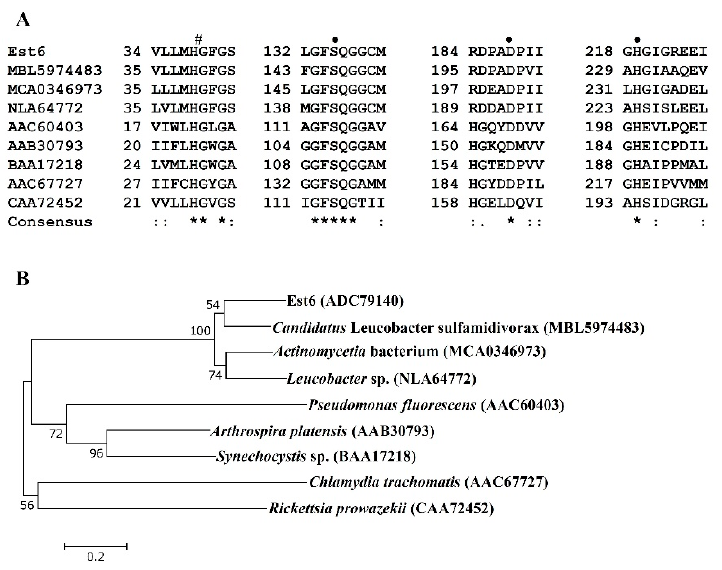
Figure 1. ( A ) Multiple alignments of Est6 and other related proteins: MBL5974483, hypothetical protein D3X82_12175 from Candidatus Leucobacter sulfamidivorax; MCA0346973, phospholipase from Actinobacteria bacterium; NLA64772, prolyl oligopeptidase family serine peptidase from Leucobacter sp.; the following five proteins belonged to family VI bacterial lipolytic enzymes [Arpigny and Jaegar, 1999]: AAC60403, esterase II from Pseudomonas fluorescens ; AAB30793, serine esterase from Arthrospira platensis ; BAA17218, serine esterase from Synechocystis sp. PCC 6803; AAC67727, predicted lysophospholipase esterase from Chlamydia trachomatis D/UW-3/CX; CAA72452, esterase from Rickettsia prowazekii . The catalytic triad is indicated as “•” above the sequence, and the oxyanion hole site HG is labeled as “#” above the sequence. All residues are identical (*), there are conserved substitutions (:) and there are semi-conserved substitutions (.) in that column in the alignment. ( B ) Neighbor-joining phylogenetic tree of Est6 and closely related proteins. The analysis was performed using the programs Clustal X 2.0 and MEGA 7.0. The percentage shown from each branch is from the 1000 bootstrap resamplings. Only the bootstrap values higher than 50% were shown. The scale bar represents 0.2 changes per amino acid.